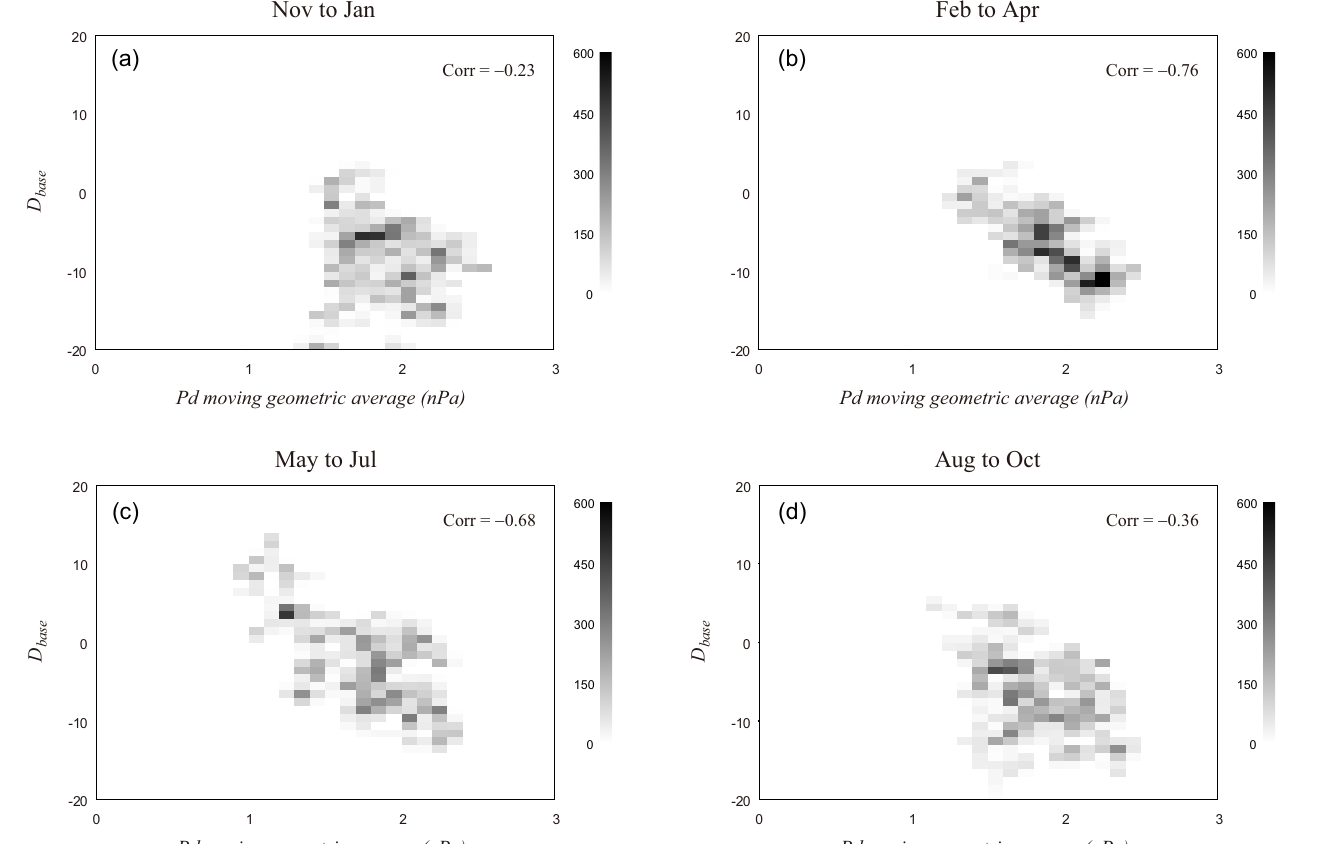
Fig. 8. Two-dimensional histograms to compare between D base and the 30-day moving geometric averages of solar-wind dynamic pressure for four seasons: (a) November to January, (b) February to April, (c) May to July, and (d) August to October. The correlation coefficient between D base and solar-wind dynamic pressure was − 0.23, − 0.76, − 0.68, and − 0.36,